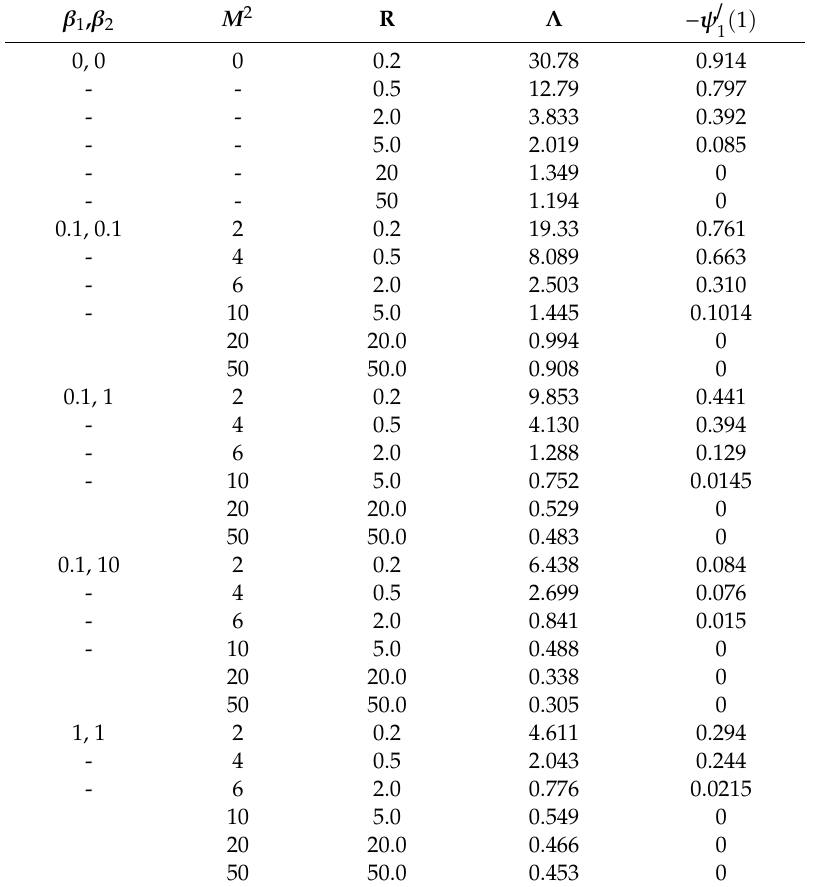
Table 2. Properties of the circular porous slider. Normalized lift Λ , normalized drag − ψ /